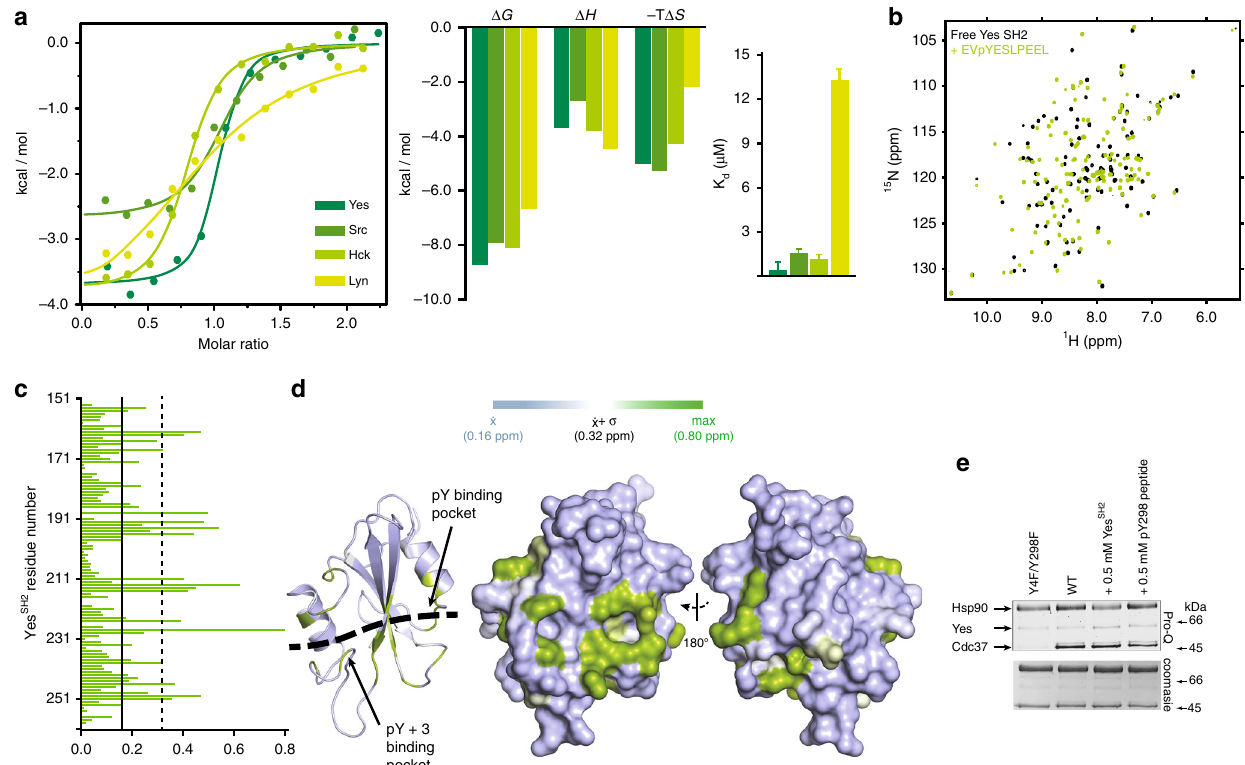
Fig. 6 Interaction of a pY298 phosphopeptide with the SH2 domains of Yes and other nRTKs. a ITC isotherms for the interaction of pYESL with the SH2 domains of Yes, Src, Hck, and Lyn (left), together with the enthalpic and entropic contributions to the free energy change (middle) and the corresponding K K fi tting of the data into a single binding site model. b Overlay of the 15 N- d values (right). Error bars in the d values correspond to the errors resulted in HSQC of Yes SH2 in the absence (black) and presence (green) of one equivalent of pYESL. c CSP as a function of Yes SH2 primary sequence. The mean and one standard deviation above the mean are marked by solid and broken lines, respectively. d Mapping of the observed CSPs on the structure of SH2. The black broken line highlights the peptide-binding site as identi fi ed in other SH2 domains. e The effect of competing concentrations of SH2 Yes or pYESL (at 0.5 mM) on the overall phosphorylation levels of Hsp90 in the context of ternary complexes formed with bRaf and Y4F/Y298F (lane 1) or wild-type Cdc37 (lanes 2 – 4), monitored by staining with Pro-Q Diamond (top) and coomassie